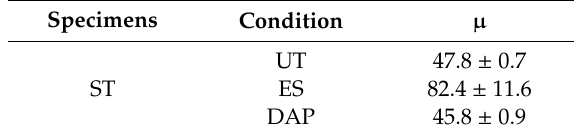
Table 3. Water vapor di ff usion resistance coe ffi cient of untreated and treated stone specimens. Specimens